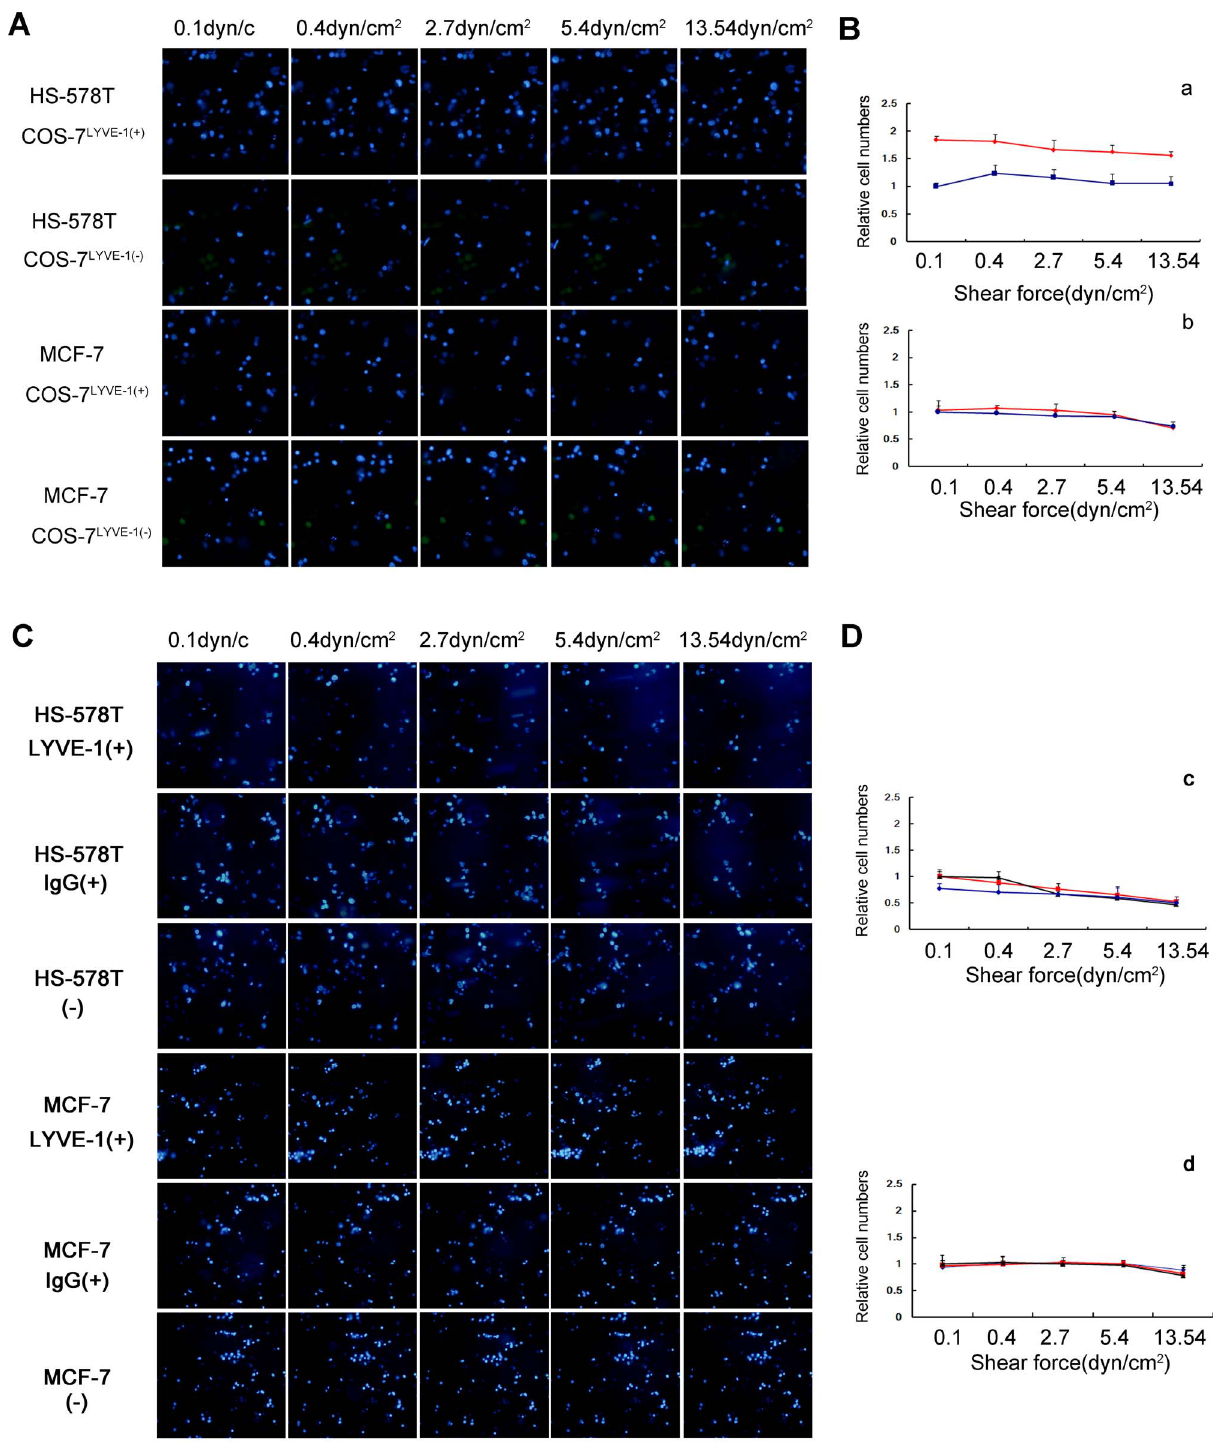
Figure 4. HA-independent adhesion of HS-578T and MCF-7 cells was visualized under flow conditions. HS-578T and MCF-7 cells were perfused over COS-7 LYVE-1( + ) and COS-7 LYVE-1( 2 ) cells at wall shear stresses of 0.1, 0.4, 2.7, 5.4 or 13.54 dyn/cm 2 for 2 min. (A) The number of adherent cells in the same field is shown as blue spheres. (B) The results are shown as the relative cell numbers of HS-578T cells (a) and MCF-7 cells (b) captured by COS-7 LYVE-1( + ) (red line) to COS-7 LYVE-1( 2 ) (blue line) cells. HS-578T and MCF-7 cells were perfused over a confluent monolayer of SVEC4-10 cells before and after blocking with LYVE-1 antibody, isotype antibody at wall shear stresses of 0.1, 0.4, 2.7, 5.4 or 13.54 dyn/cm 2 for 2 min. (C) The number of adherent cells in the same field is shown as blue spheres. (D) The results are shown as the relative cell numbers of HS-578T cells (c) and MCF-7 cells (d) captured by SVEC4-10 cells blocking with LYVE-1 (blue line), SVEC4-10 cells blocking with isotype control (red line) to SVEC4-10 cells without treatment (black line). The error bars represent the mean 6 SD of the number of cells bound. Data are representative of 3 independent experiments.